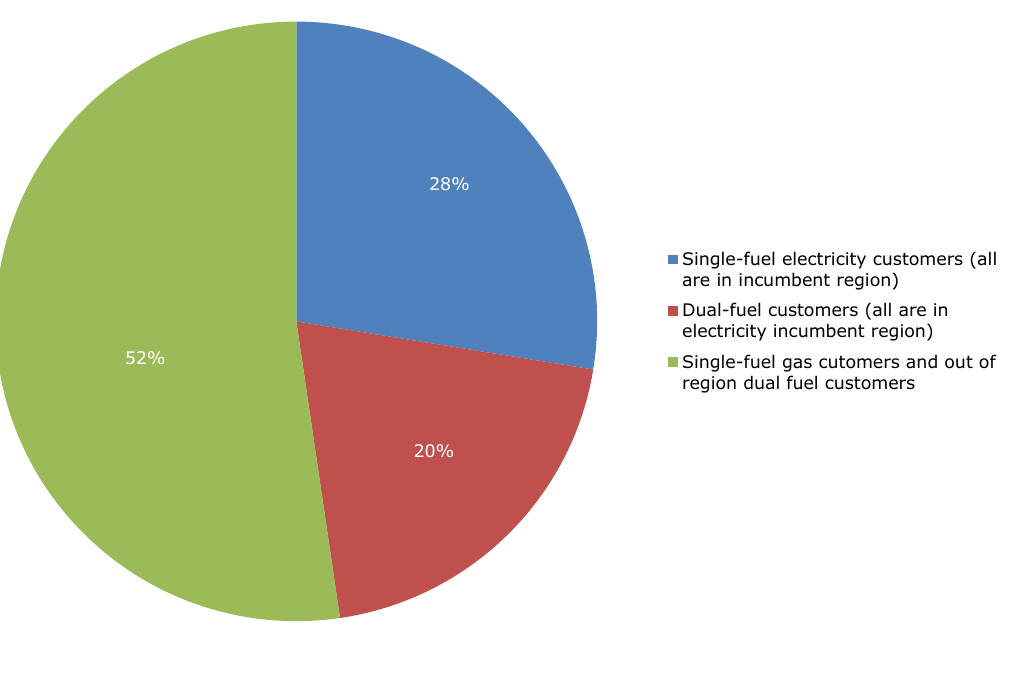
Source: Ofgem calculations based on supplier customer account data submitted for Ofgem’s regular market monitoring activities, as at July 2013